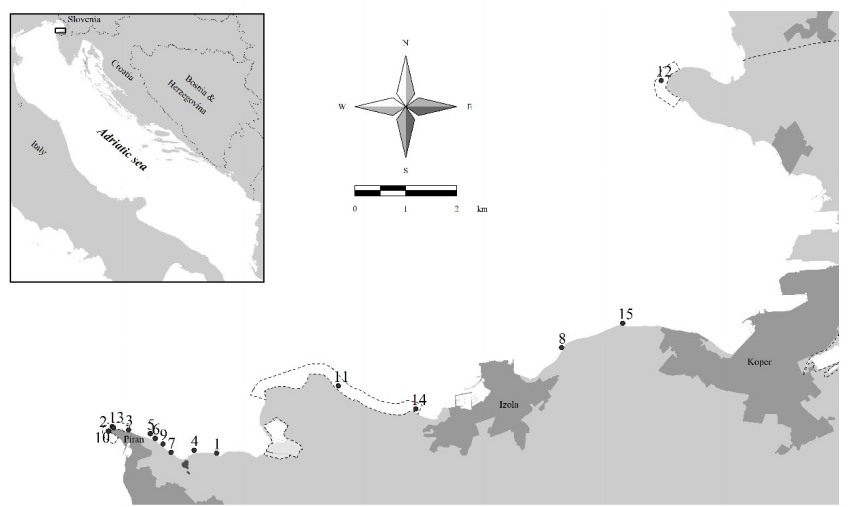
Figure 1. Sampling sites with canopy-forming macroalgae considered in the present study in Slove- nian coastal waters (for details, see Table 1). The boundaries of three MPAs are outlined on the map (from left to right: Cape Madona Nature Monument near Piran, Strunjan Nature Reserve, and Debeli rtiˇc Nature Monument). The three main coastal cities are Koper, Izola, and